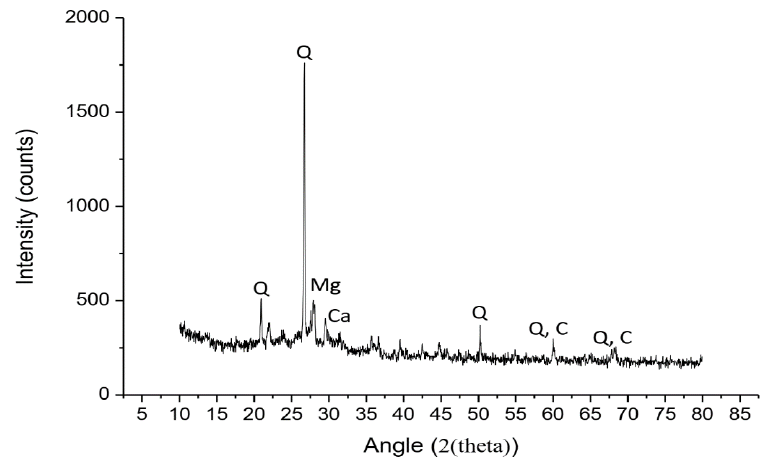
Figure 1. XRD analysis of SCBA.